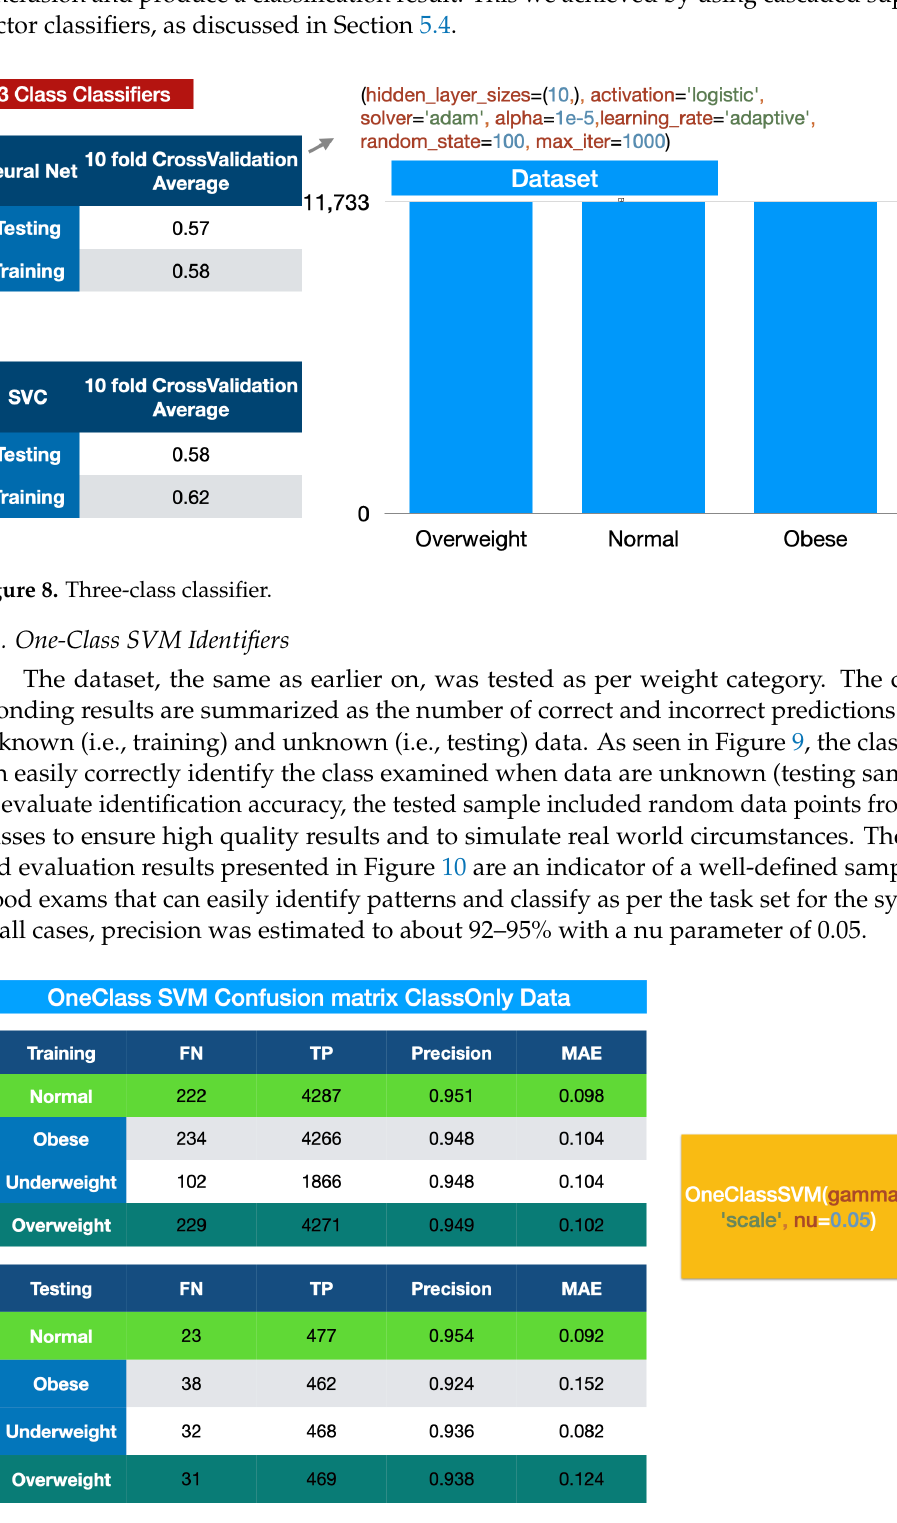
Figure 9. One-class